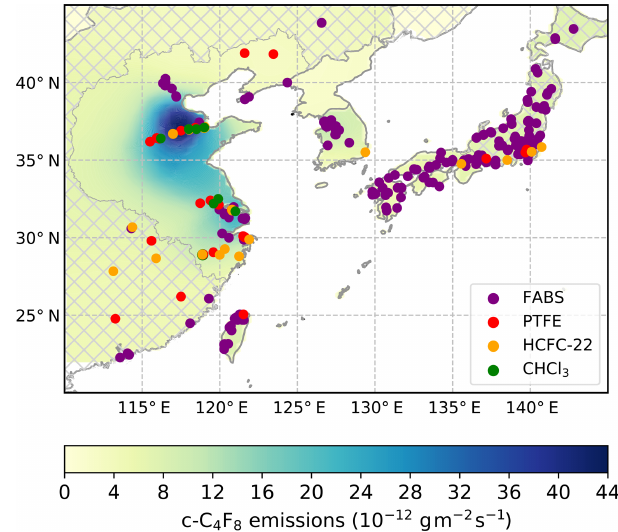
Figure 7. Mean c -C 4 F 8 emission strength (shades of green and blue, 10 − 12 gm − 2 s − 1 ) in eastern Asia from 2010 to 2017 de- termined by the NAME-HB inversion from measurements at the Gosan station, Jeju Island, South Korea. The hatching indicates ar- eas for which emissions are not reported due to relatively low sen- sitivities of the inversion. Emissions predominantly occur in the densely industrialized Shandong, Tianjin, and parts of Henan and Hebei provinces south/southwest of Beijing as well as in Shang- hai and neighboring provinces Jiangsu (to the north), Anhui (to the west), and Zhejiang (to the south) of the Yangtze River Delta region. Shown are industries with potential c -C 4 F 8 emissions: semiconductor fabrication plants (FABS, purple dots, https://en. wikipedia.org/wiki/List_of_semiconductor_fabrication_plants, last access: 3 December 2018; http://www.10stripe.com/featured/map/ semiconductor-fabs.php, last access: 3 December 2018; and other sources) and TFE–HFP–PTFE–FEP production facilities (PTFE, red dots, https://www.qianzhan.com/analyst/detail/220/ 170629-c33a2ca7.html, last access: 12 December 2018; and other sources). HCFC-22 (orange dots) and chloroform (CHCl 3 , green dots) production facilities are shown as the TFE and HFP monomers needed to produce PTFE and FEP fluoropolymers are produced via pyrolysis of HCFC-22 and c -C 4 F 8 is an intermediate/by-product in this process, while HCFC-22 is manufactured from CHCl 3